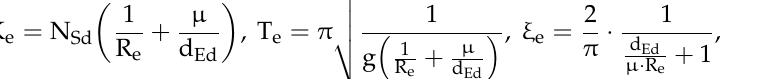
Figure 4. ( a ) DCCSS bearing and ( b ) linear equivalent model.